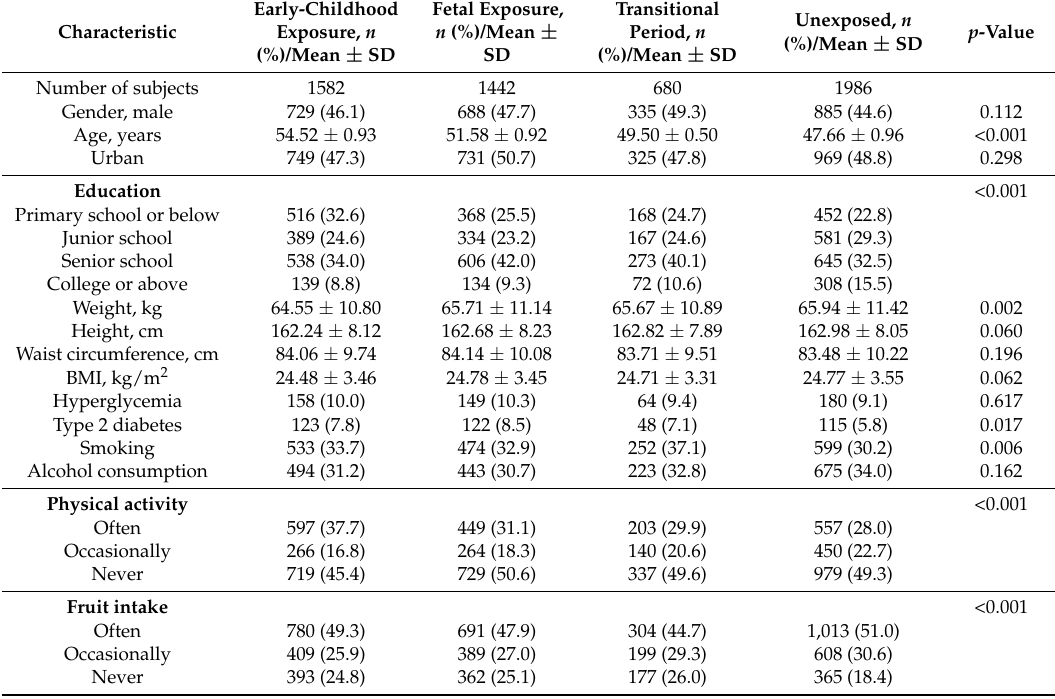
Table 1. Baseline characteristic of subjects in the four cohorts based on birth